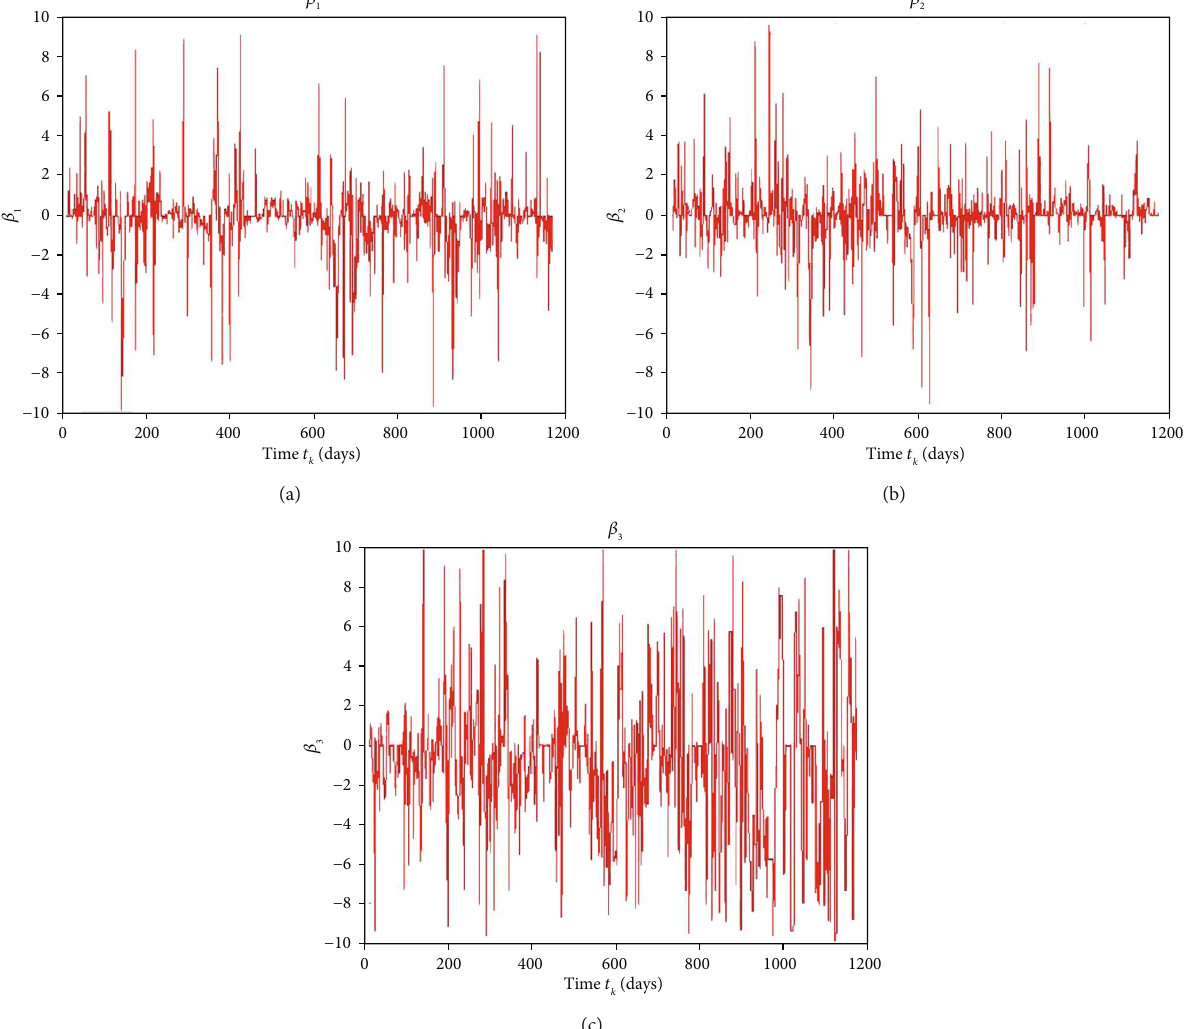
Figure 12: The graph of β